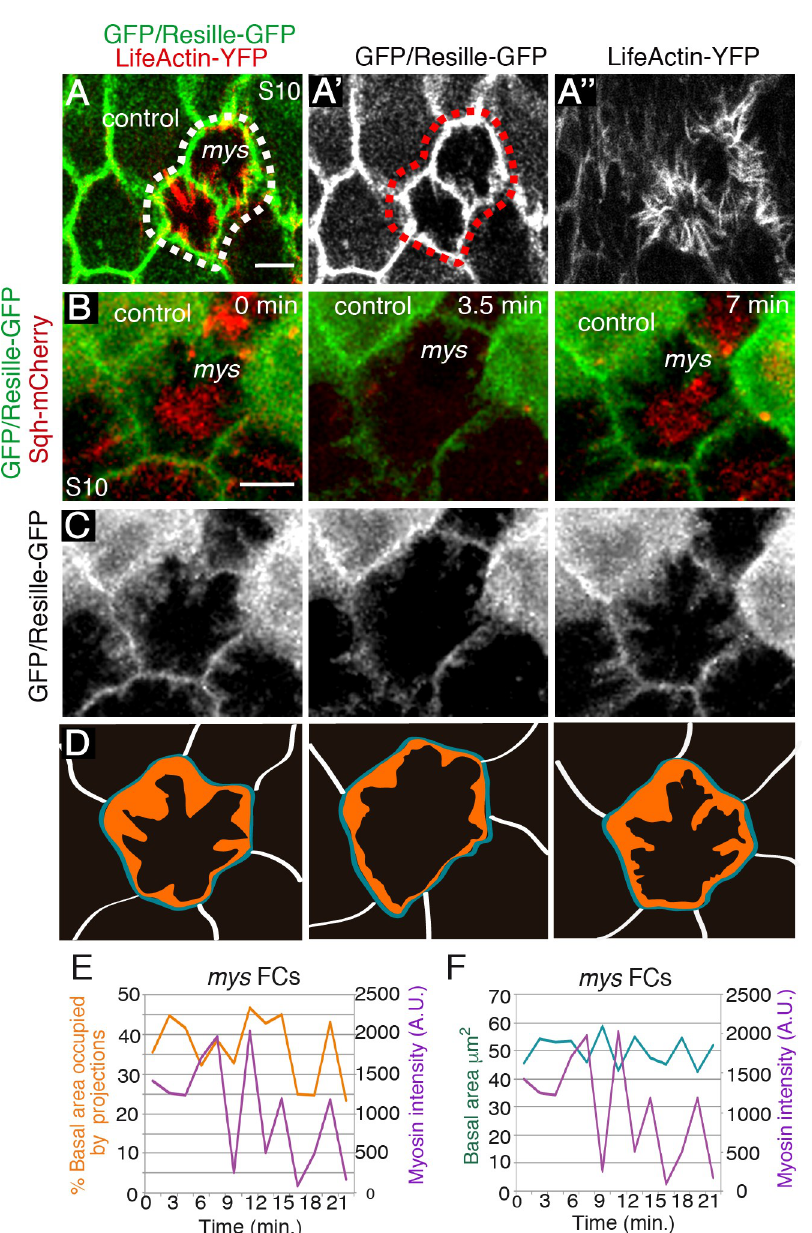
Fig 2. Loss of integrins results in reorganisation of the basal actin cytoskeleton. (A-A”) Confocal micrographs of mys FC clones in living egg chambers expressing LifeActin-YFP (red) and the membrane marker Resille-GFP (green). mys FCs (GFP-negative) form abnormal actin-rich protrusions. (B-D) Time-lapse series of one representative mys FC (GFP-negative) labelled with Sqh-mCherry (red) and Resille-GFP (green). (D) The total area occupied by projections at different time points is coloured in orange. In blue, outline of the basal surface of the cell. (E, F) Simultaneous quantification of basal myosin changes and % of total basal surface occupied by projections (E) or total basal area (F) in one representative mys FC. Scale bars, 5 μ